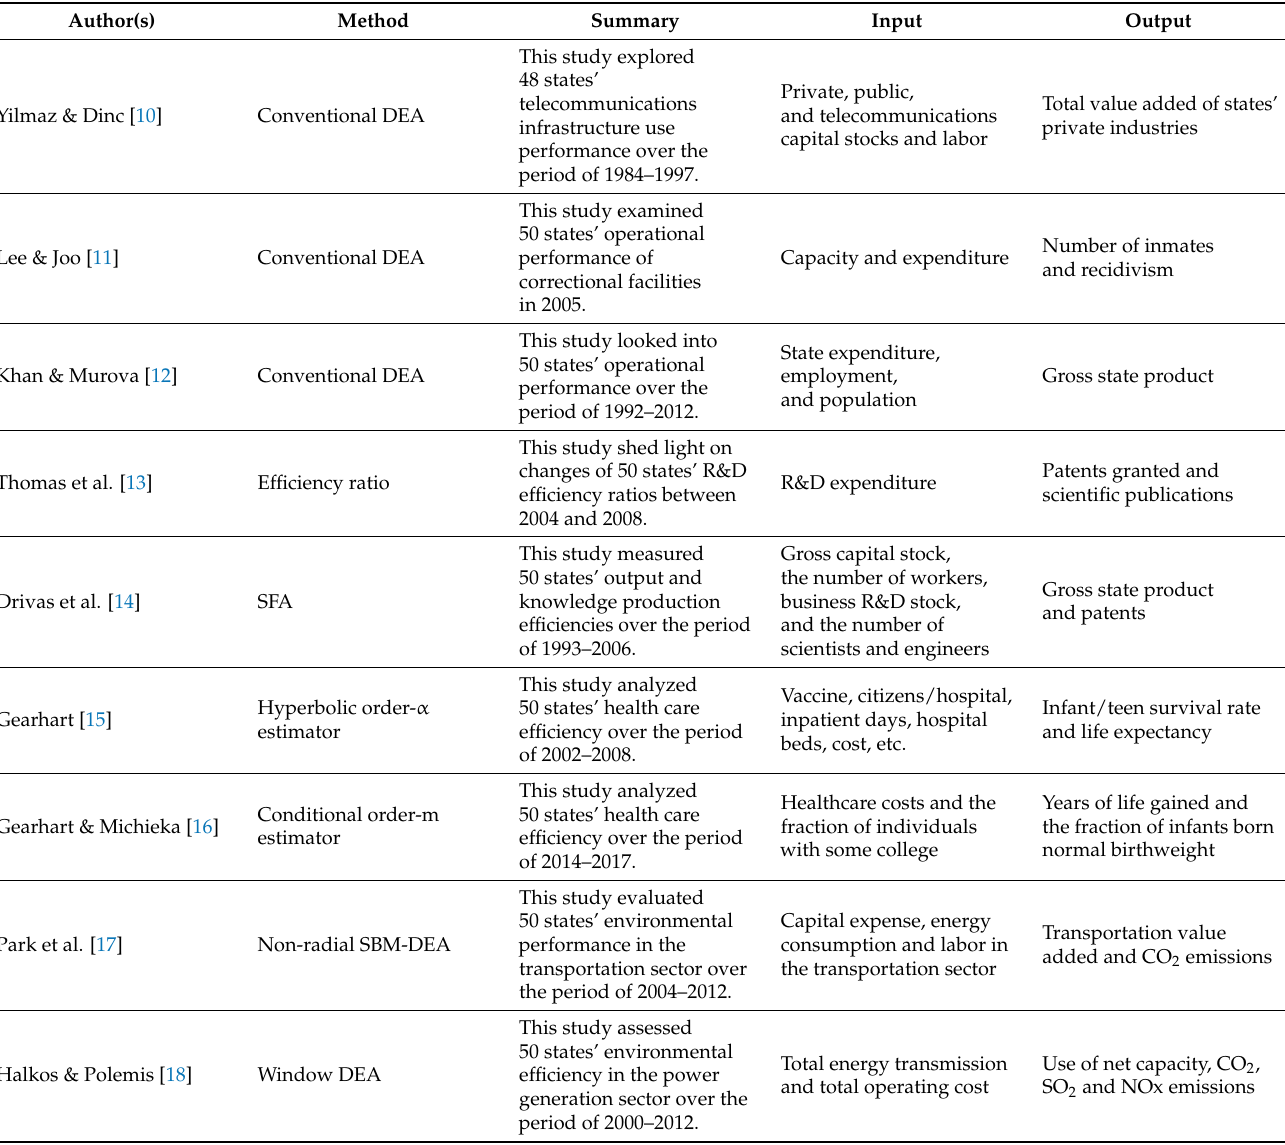
Table 1. Previous Assessments on Performance of U.S.